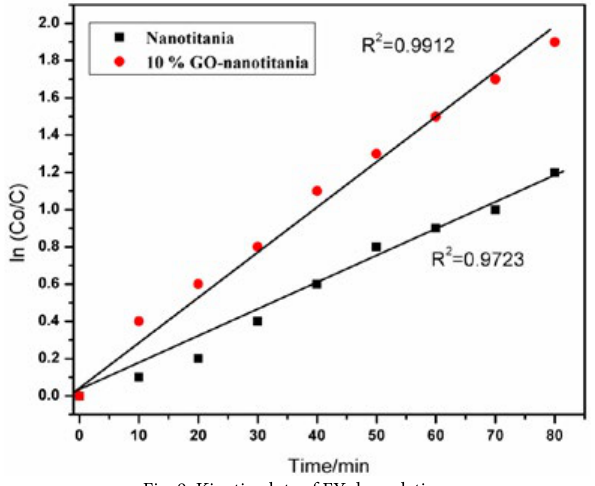
Fig. 9 Kinetic plots of EY degradation. Fig. 9: Kinetic plots of EY degradation. [Catalyst load] = 8 mg, [EY] = 2.33 x 10 -5